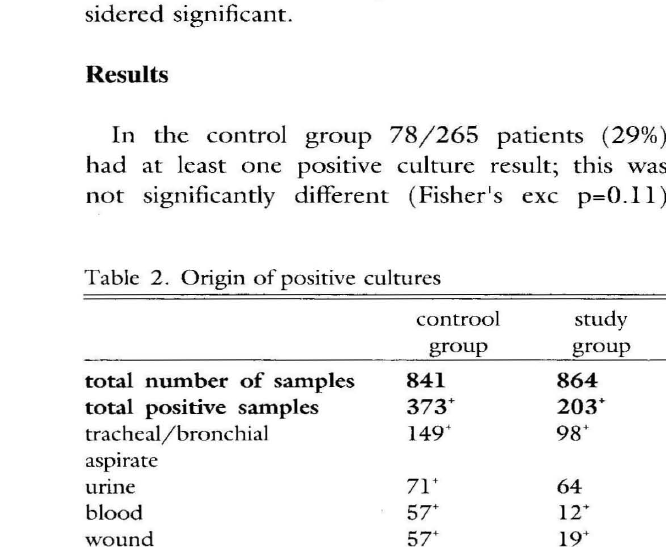
Table 3. Micro-organisms isolated Micro-organism